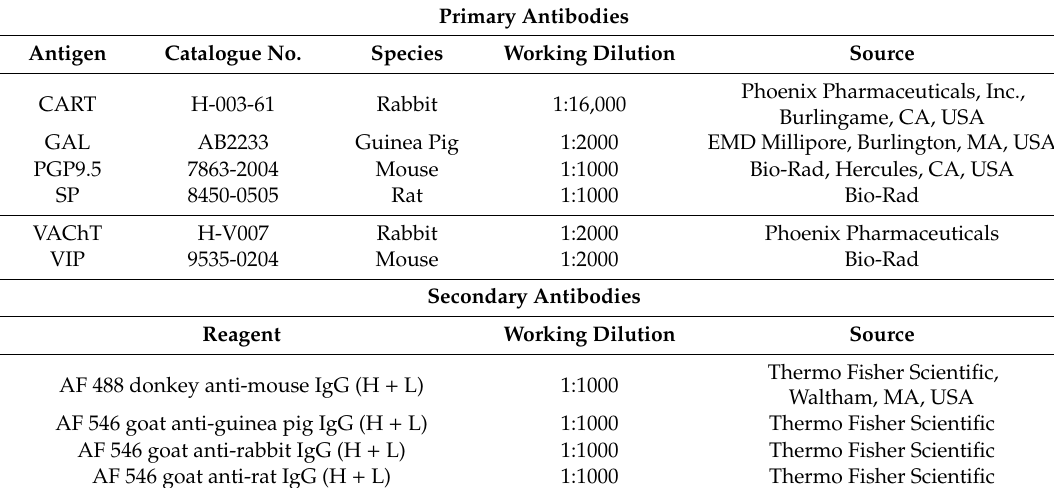
Table 1. Antibodies used in the present study.